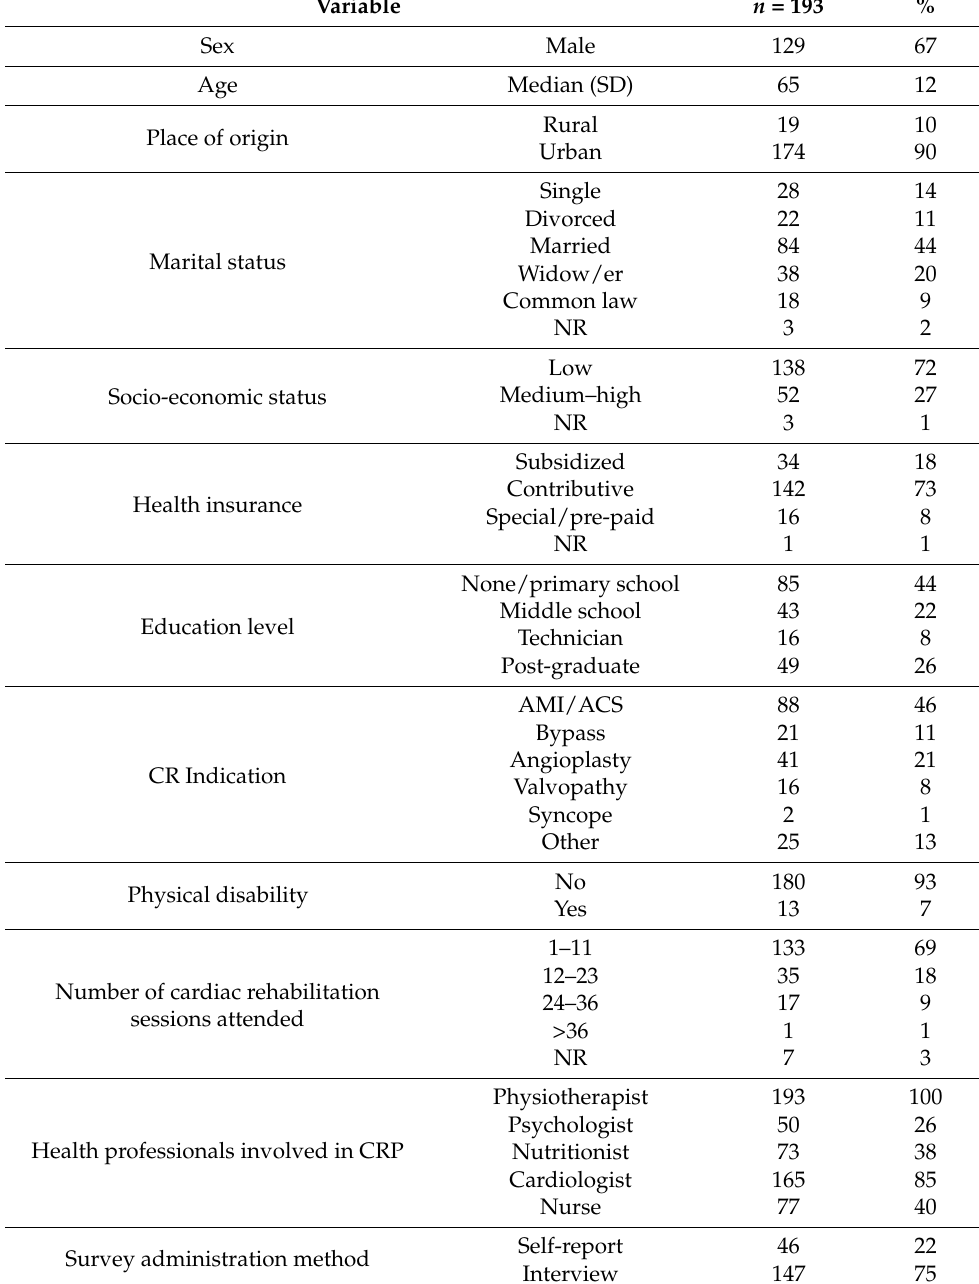
Table 1. Baseline characteristics of the